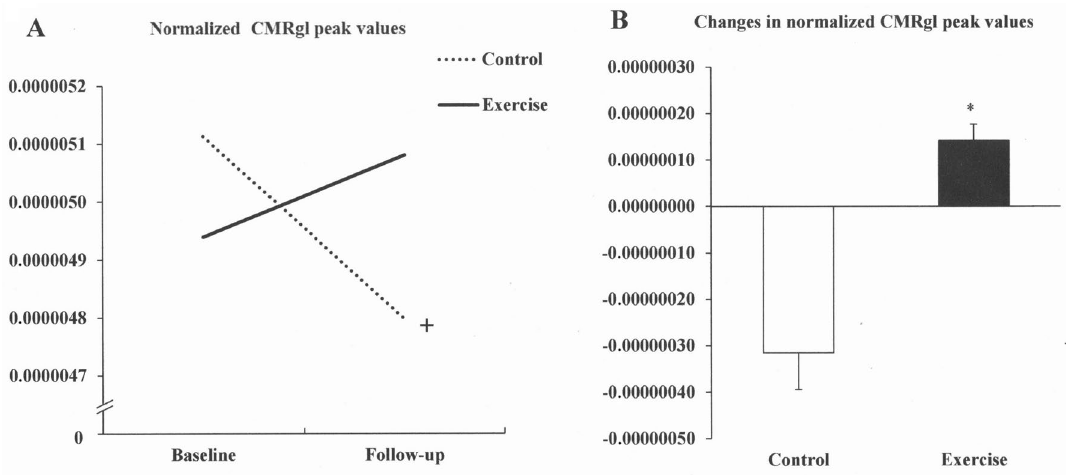
Figure 4. ( A ) Normalized cerebral metabolic glucose rate (CMRgl) peak values (voxel values extracted from the coordinate of maximal significance) within and between control and exercise-trained groups; ( B ) Delta changes in CMRgl peak values in patients with obstructive sleep apnea in the control group and exercise-trained group. + P < 0.05 Significant difference compared with respective baseline values (2-way ANOVA). * P < 0.05 Control versus training group (Unpaired t